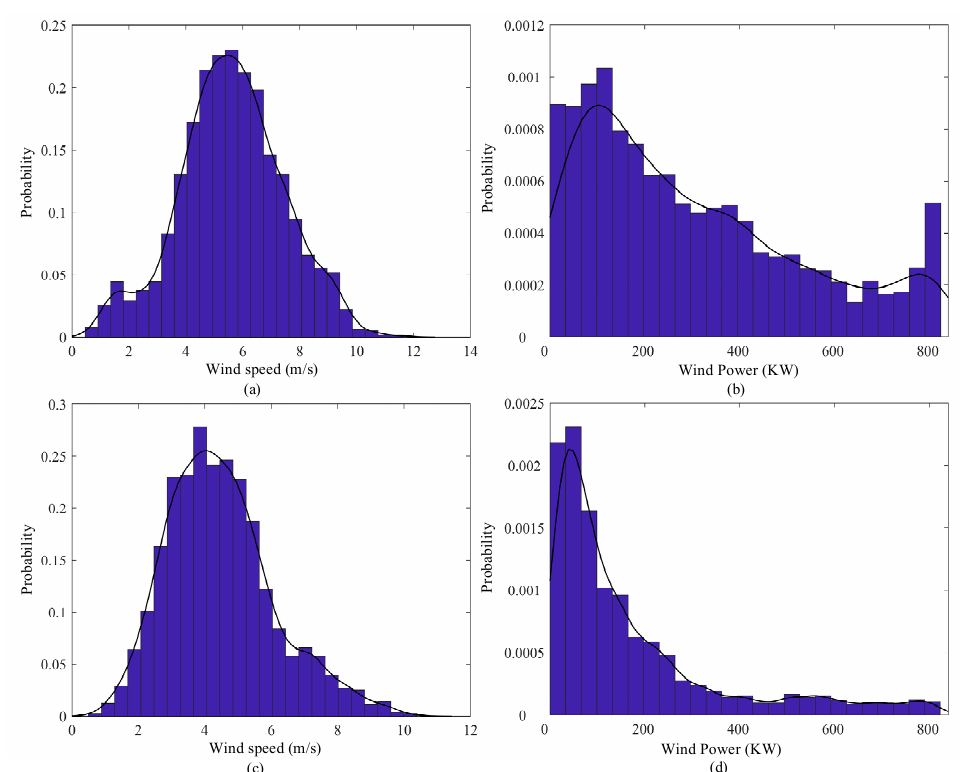
Figure 6. Wind Energy Probability Chart. ( a ) Wind speed probability distribution of wind turbine No. 2, ( b ) Power probability distribution of wind turbine No. 2, ( c ) Wind speed probability distribution of wind turbine No. 3, ( d ) Power probability distribution of wind turbine No. 3. To quantitatively analyse the prediction results and verify the performance of the proposed ultra-short-term wind power portfolio prediction model, root mean square error (RMSE), mean absolute error (MAE), and mean absolute percentage error (MAPE) were calculated. The index of agreement (IA) was proposed by Willmott as a standardized measure of the degree of model prediction error, and its value varies between 0 and 1. A value of 1 indicates a perfect match, whereas a value of 0 indicates no agreement at all. The IA can detect additive and proportional differences in the observed and forecasted means and variances; thus, it can be used to confirm the validity of overperformance [36]. The Pearson correlation coefficient is a linear correlation coefficient that reflects the correlation degree between two variables and is also known as Pearson product-moment correlation coefficient [37]. In this study, the Pearson correlation coefficient is used to determine the correlation between the predicted and actual wind power. ρ = 1 indicates a completely linear correlation between two variables, Whereas ρ = 0 indicates a wireless correlation between two variables. The closer the ρ is to 1, the stronger is the linear relationship between two variables. All of these indicators are used to estimate the proposed